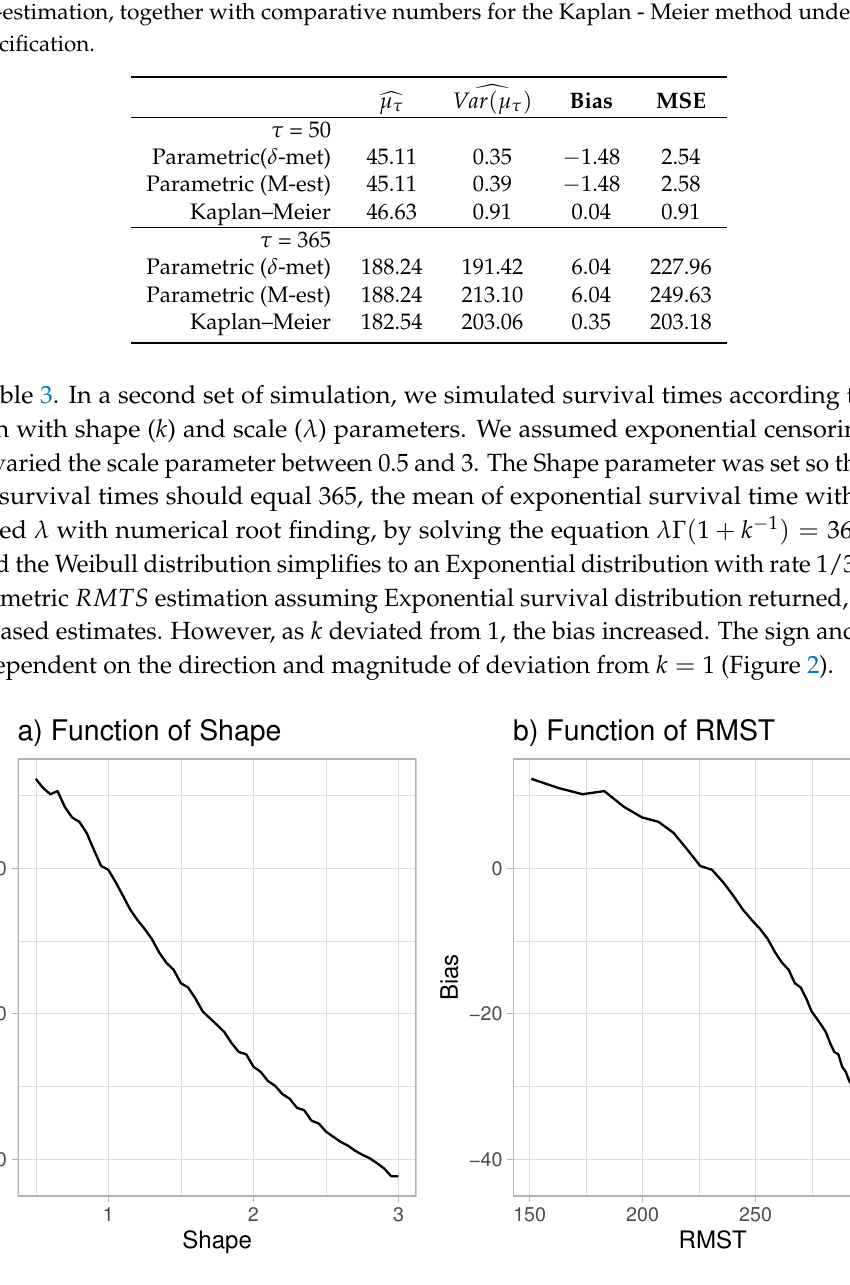
Figure 2. Bias under model misspecification of the parametric estimator as a function of restriction time ( a ) and censoring percentage ( b